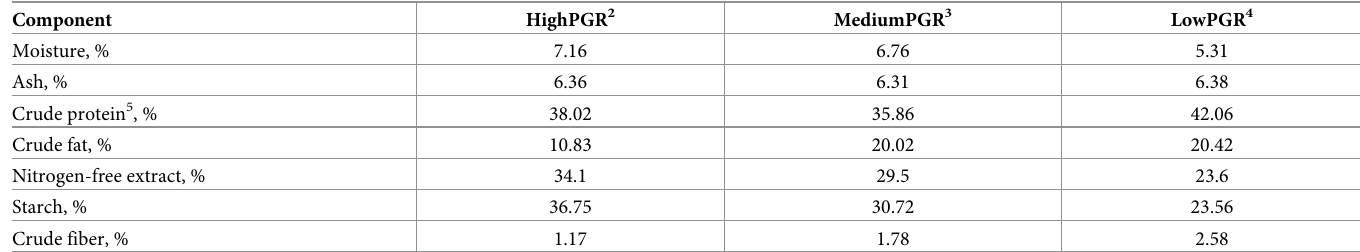
Table 1. Proximate analysis of commercial diets differing in PGR 1 .